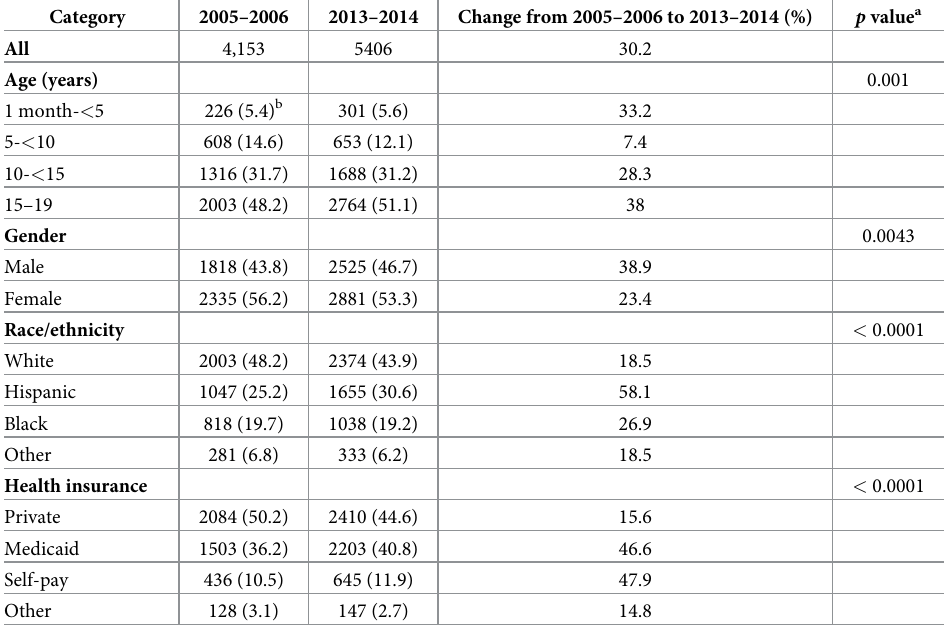
Table 3. Changes in the volume of hospitalizations with diabetic ketoacidosis in